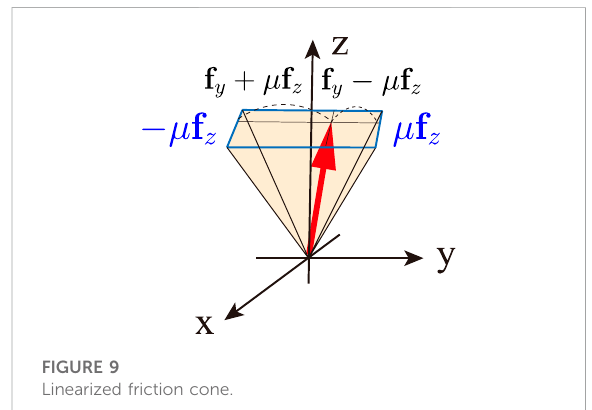
FIGURE 9 Linearized friction